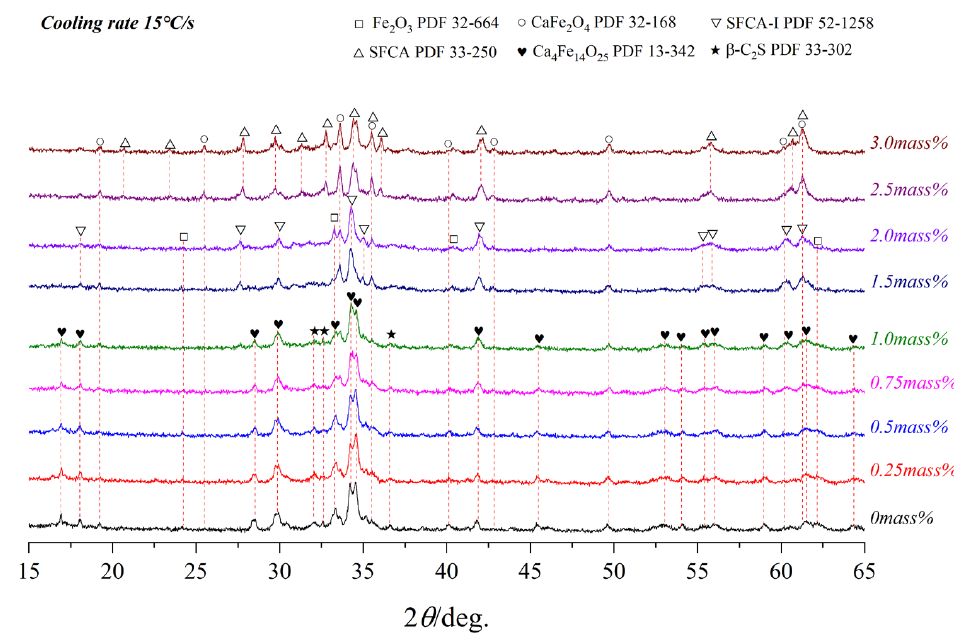
Figure 9. XRD patterns of samples with different Al 2 O 3 content cooled at 15 °C/s.